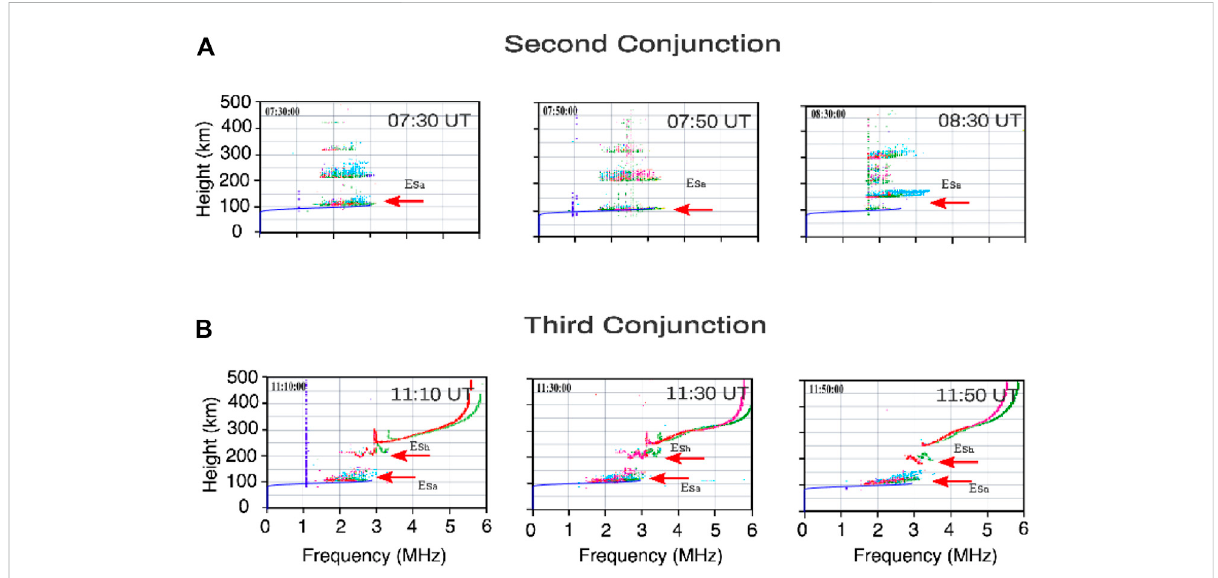
FIGURE 14 Ionograms from Digisonde located at Cachoeira Paulista during the second (A) and third (B) conjunctions. The red arrows show the Es a layer presence and the blue line is referent the plasma modeled frequency (MHz)